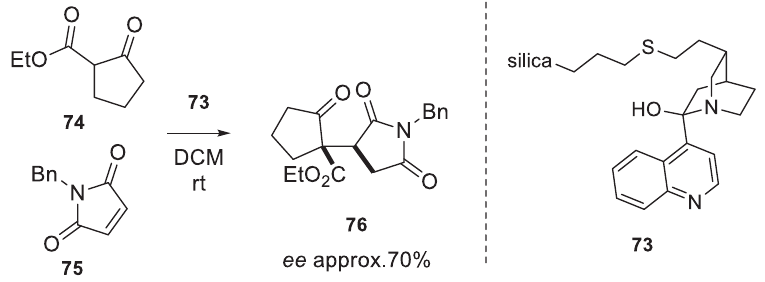
Figure 19 . Enantioselective Michael addition, from Ref.